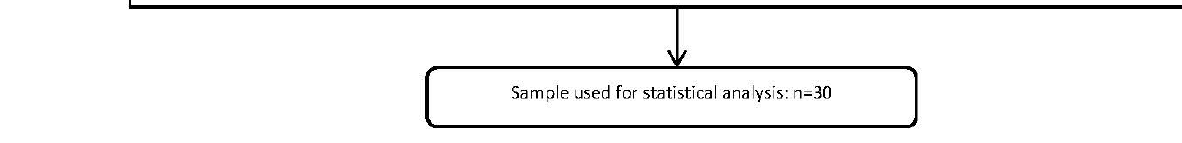
Figure 1. Flowchart of participant recruitment.